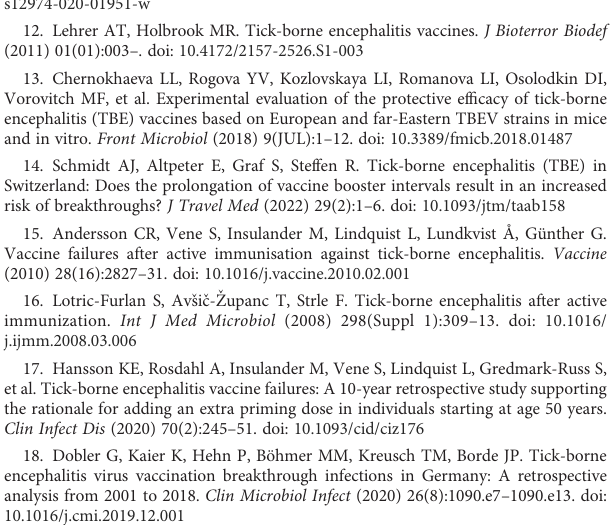
Box plots of the scoring values of immunohistochemistry for TBEV (A, D) , T cell marker CD3 (B, E) and microglia/macrophage marker Iba1 (C, F) of ileum (A-C) and colon (D-F) for each experimental group. Signi fi cant differences detected by pairwise Wilcoxon rank-sum tests after non- parametric ANOVA are indicated by asterisks (* p < 0.05; ** p< 0.01; *** p < 0.001). Mice that differed in their clinical state from other mice in the control and LGTV serum recipient group are highlighted as rhombus shaped symbols in the box